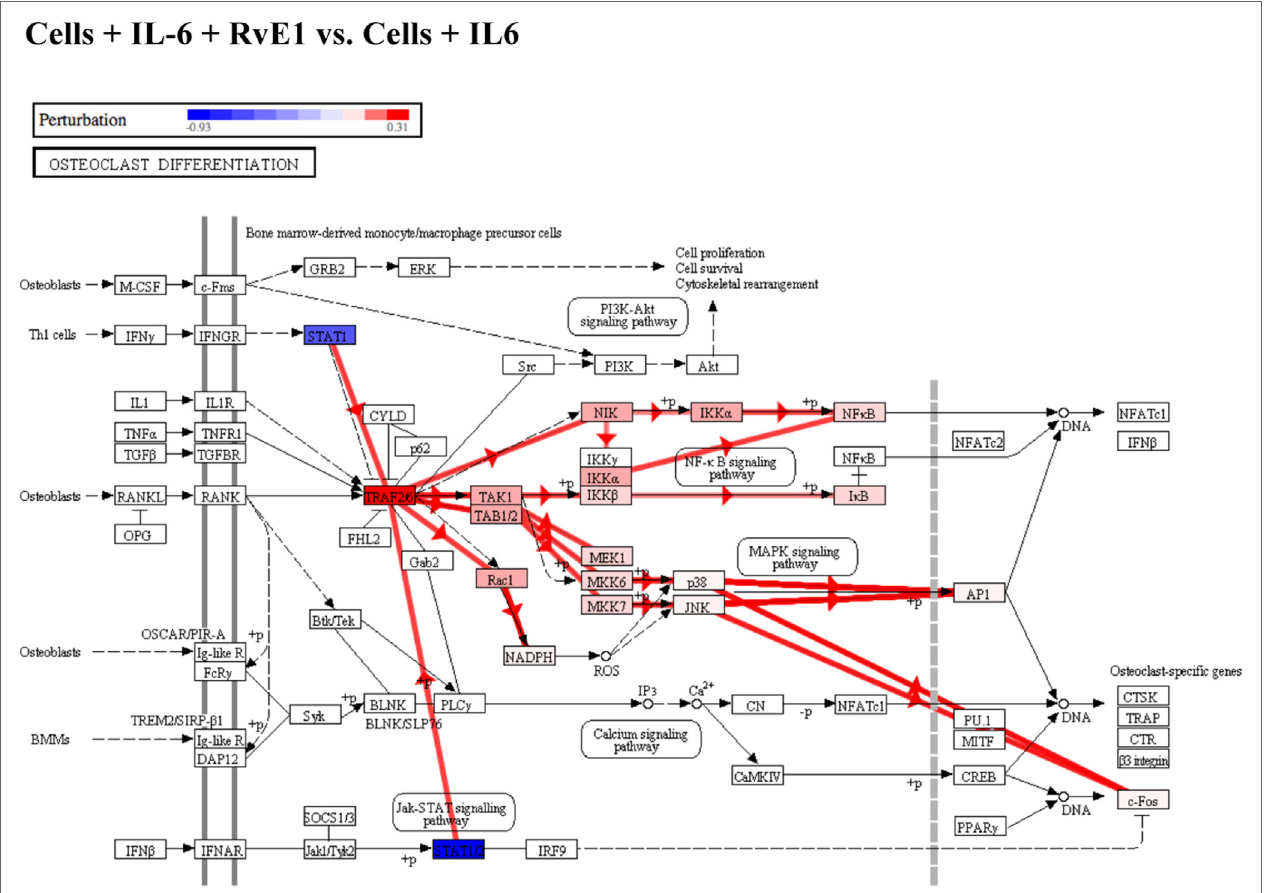
FigUre 4 | Osteoclast differentiation pathway perturbation after stimulation with interleukin (IL)-6 with or without resolvin E1 (RvE1). Using Illumina’s iPathwayGuide application, a significant perturbation in the osteoclast differentiation pathway was noted after stimulation of osteoblasts with IL-6. Upregulation of IL-1 lead to promotion of downstream signaling affecting the MAPK and NF κ B signaling pathways leading to upregulation of osteoclast differentiation. After treatment with RvE1, downregulation of STAT1 led to inhibition of downstream signaling affecting the MAPK and NF κ B signaling pathways leading to downregulation of osteoclast